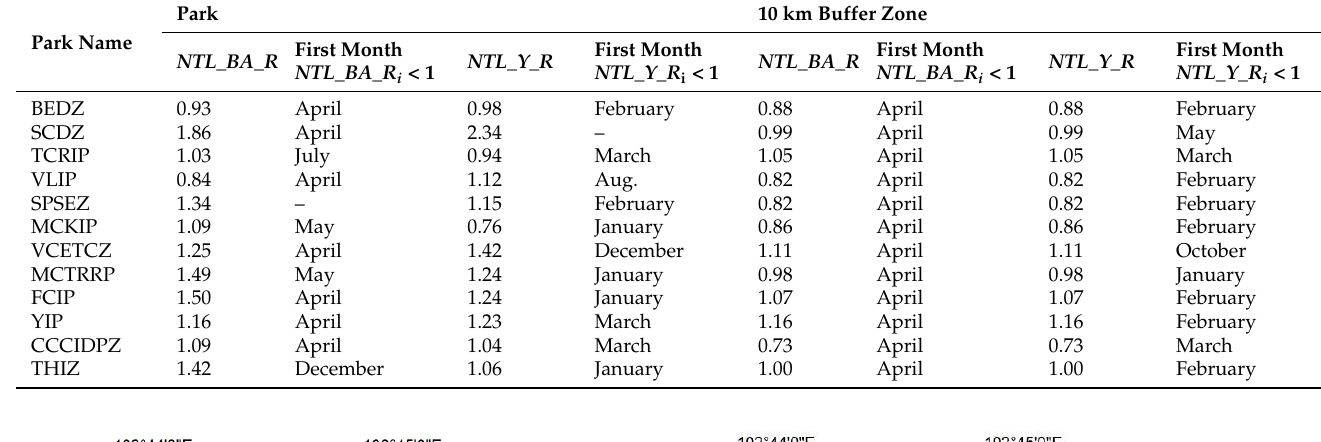
Table 3. Influence of COVID-19 on parks and surrounding 10 km buffer zones.